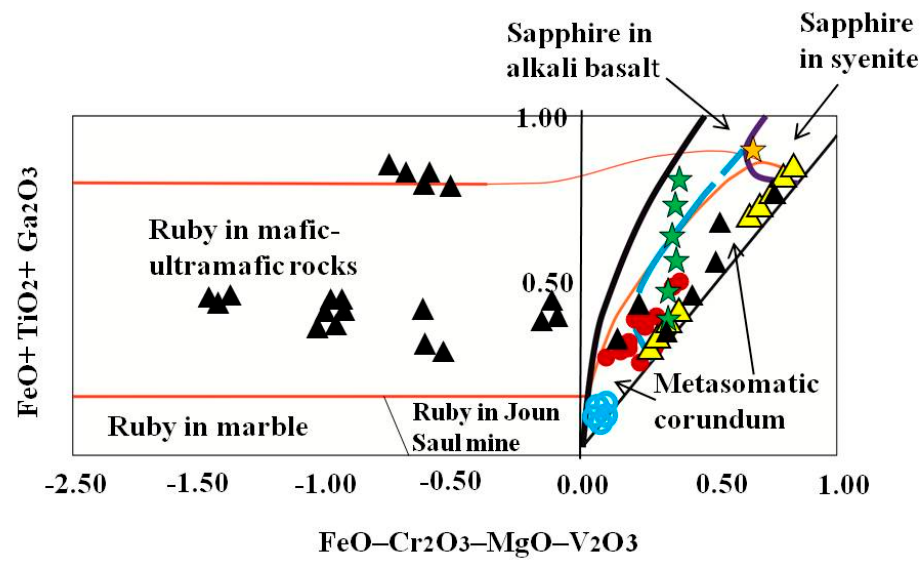
Figure 9. A FeO – Cr 2 O 3 – MgO – V 2 O 3 versus FeO + TiO 2 + Ga 2 O 3 discriminant diagram (wt. %) is modified after Giuliani et al. (2014) [40] with extended “magmatic / syenitic” field with plotted corundum-sapphire within kyshtymites (red circles), Ilmen sapphires within syenite pegmatites (yellow triangles) [2], and within the meta-ultramafic host rocks (blue circles) [3]. The data on sapphires associated with xenoliths in alkali basalts (Gortva in Slovakia—green star; Loch Roag in Scotland—yellow star) were modified after Uher et al. (2012) [38]. The data on sapphires associated with ultramafic lamprophyre dike in Yogo Gulch (USA) (black triangles) are after [39]. Blue dotted line shows the extension of “magmatic / syenitic” sapphire field.